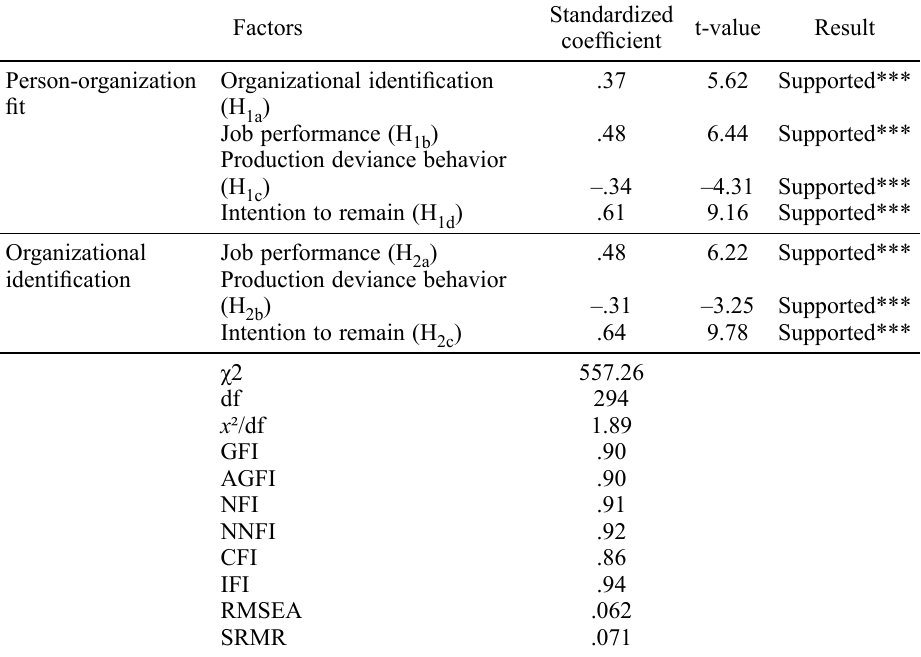
Table 3. The result of